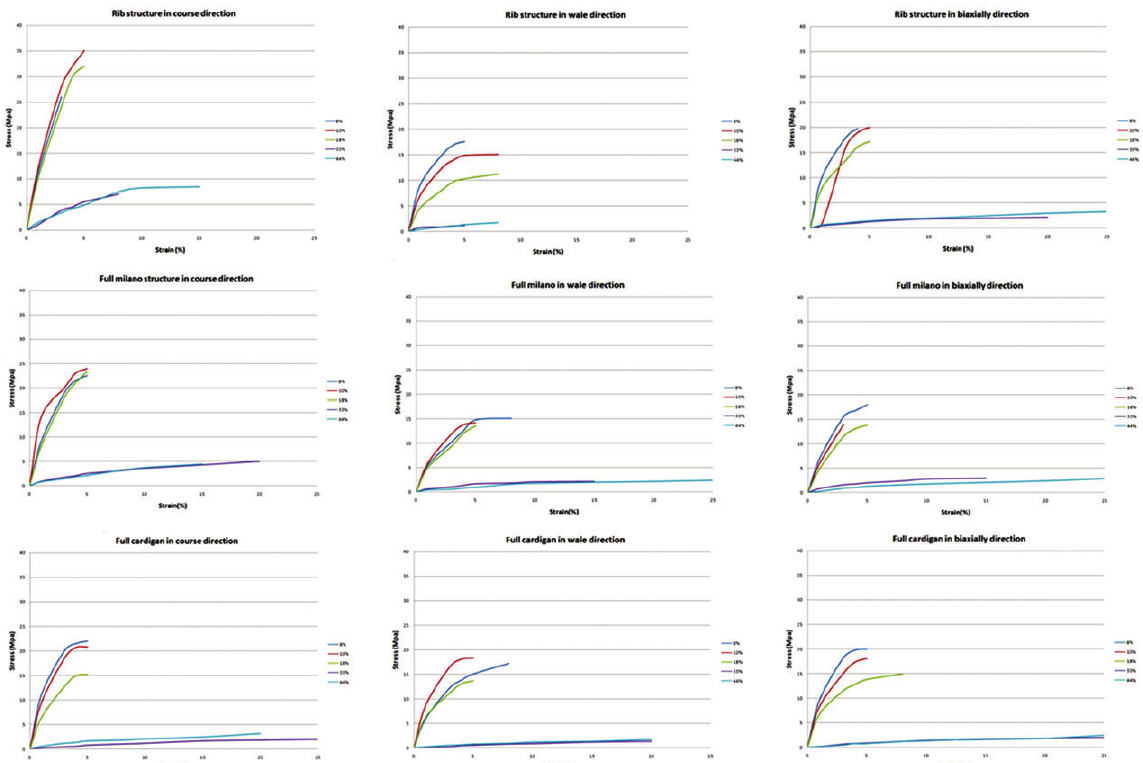
Figure 2 Stress-strain curvatures of fabric